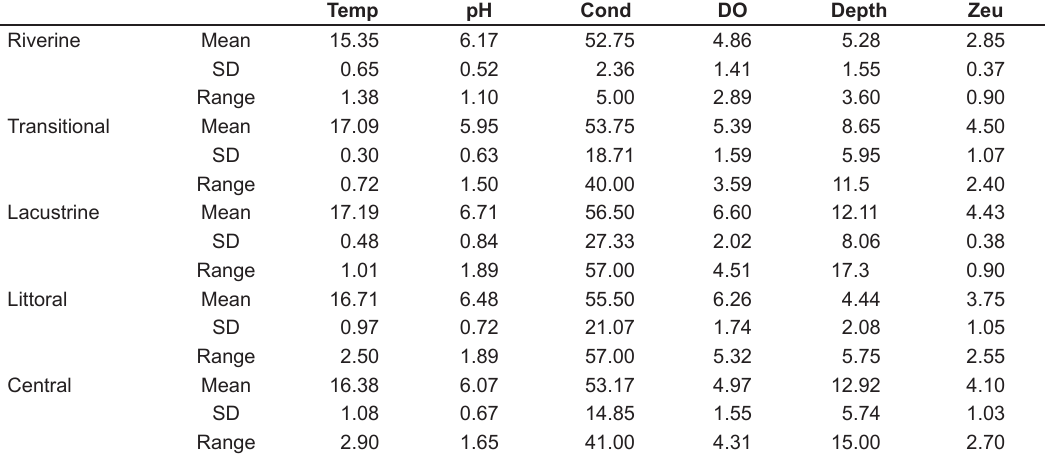
Table 4. Summary of water variables values recorded in situ - mean, range and standard deviation (SD) - in the Itupararanga Reservoir, High Sorocaba Basin, SP, Brazil: during dry season (June and August, 2010) measure for river- ine, transitional and lacustrine zones as well for littoral and central regions. Temp.= temperature (°C), Cond =